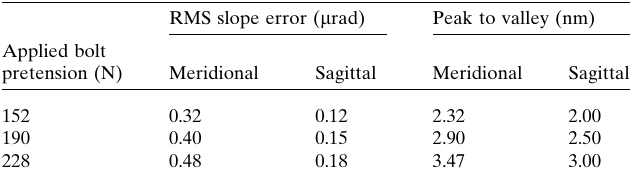
Table 1 Peak-to-valley of the figure error and RMS slope errors across the centre line of the optical surface of the